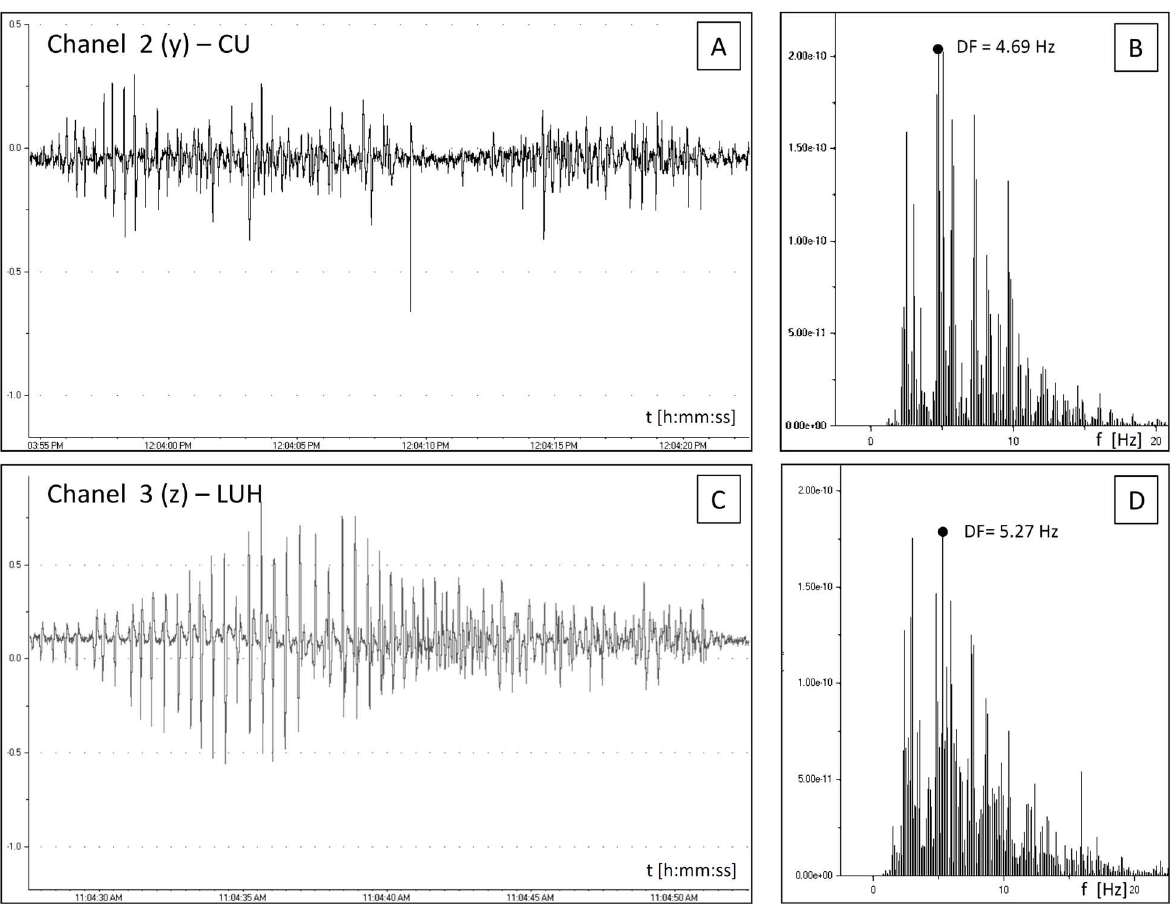
Fig 3. Fourier analysis of highly synchronized EMG signals. EMG signals from the corpus uteri (A, B) and left uterine horn (C, D) in time (A, C) and frequency (B, D) domains.